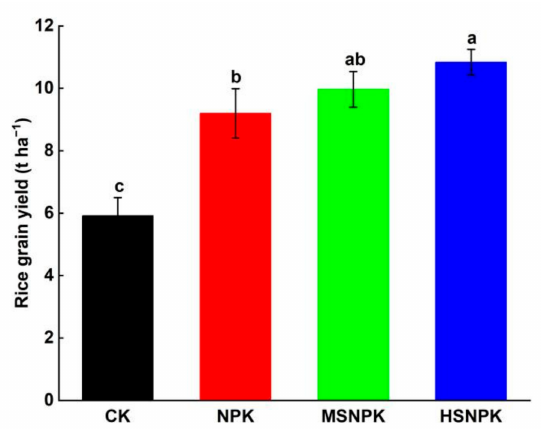
Figure 9. Average rice grain yield under different treatments. The values are means ± SD ( n = 3). Different letters mean statistically significant differences at the 0.05 level. CK: unfertilized control; NPK: mineral NPK fertilizer; MSNPK: moderate wheat straw incorporation (3 t ha − 1 ) plus NPK; HSNPK: high wheat straw incorporation (6 t ha − 1 ) plus